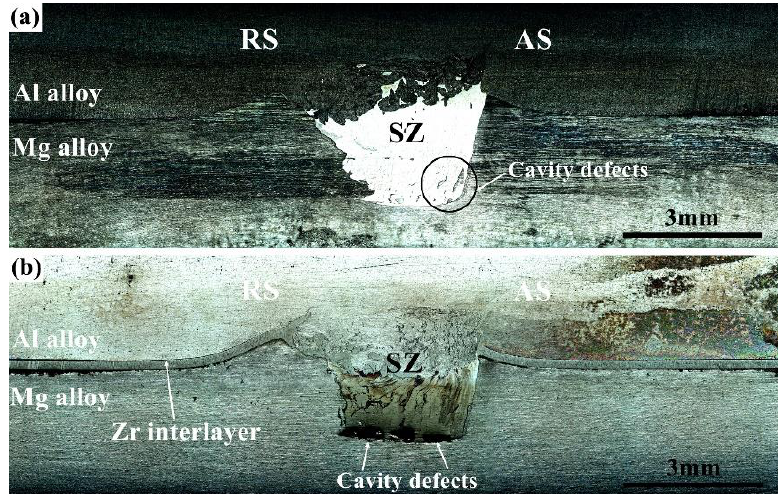
Figure 3. Cross-sectional profiles of the ( a ) Al/Mg and ( b ) Al/Zr/Mg joints.